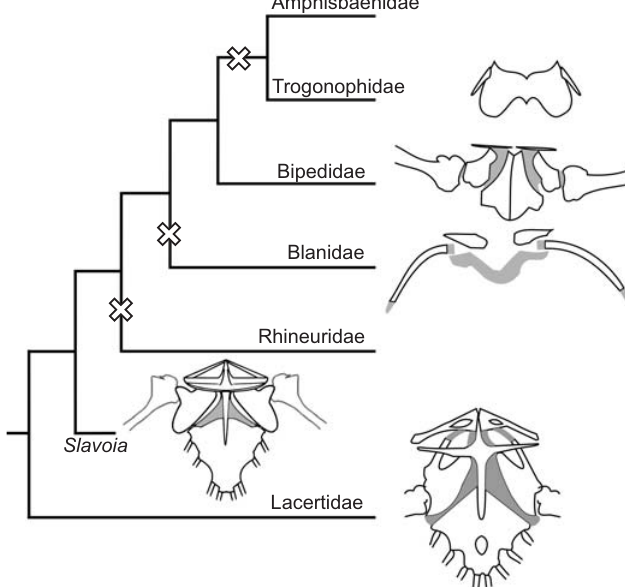
Fig. 13. Evolution of pectoral girdles of Lacertidae, Slavoia darevskii , and families of Amphisbaenia. Crosses mark at least three independent losses of the forelimbs among worm lizards.